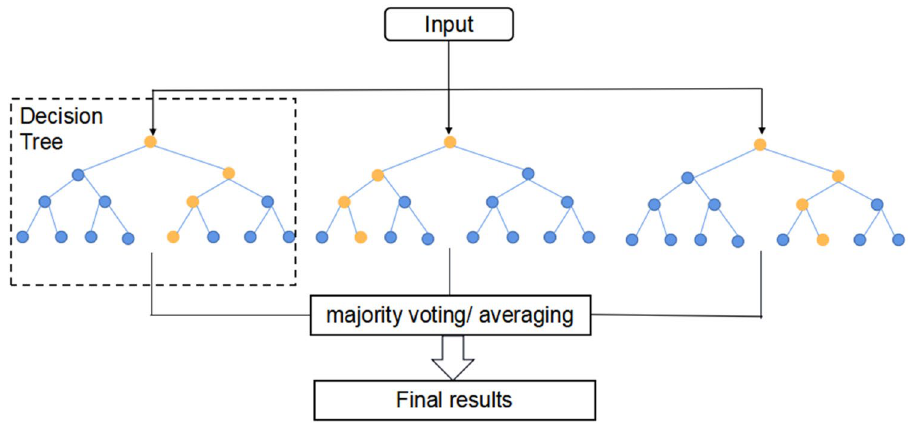
Figure 3. Working principle of